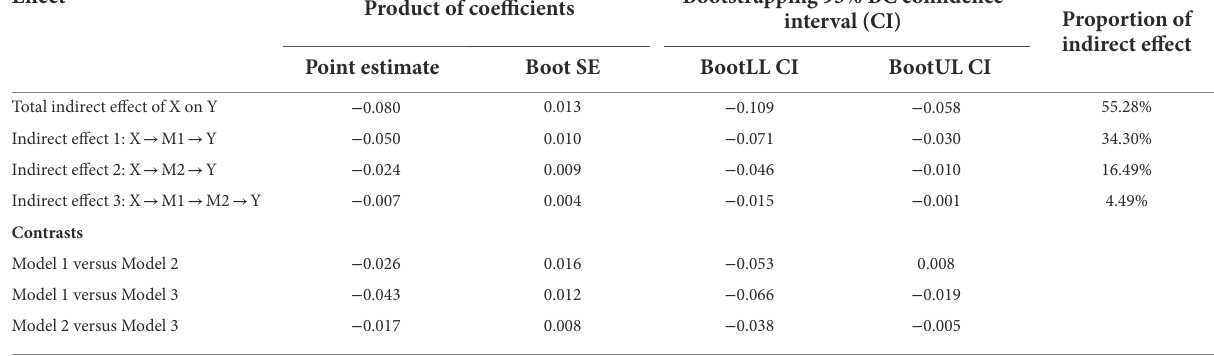
TABLE 3 Comparison of indirect effects of organizational support on insomnia mediated by psychological capital and ERR.